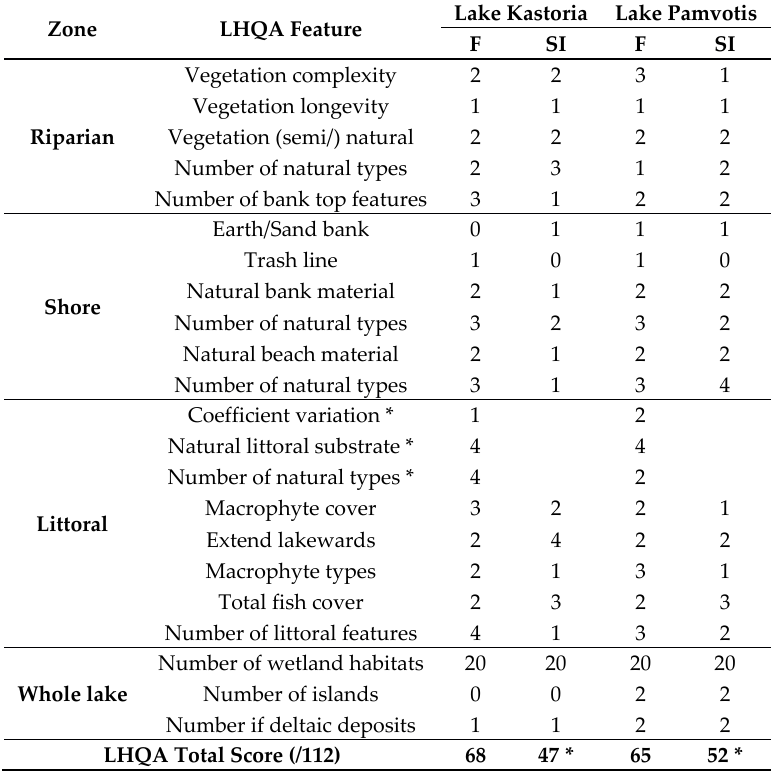
Table 2. Scores of Lake Habitat Quality Assessment (LHQA) index for each metric for lakes Kastoria and Pamvotis based on the different approaches (F: foot, SI: satellite imagery).